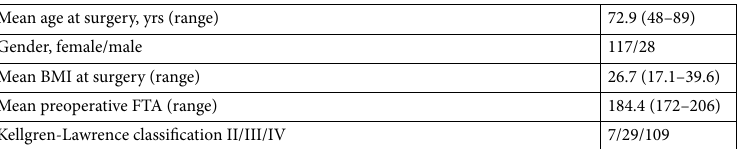
Table 1. Summary of demographic data for patients included in this study. BMI, body mass index; FTA, femorotibial angle.